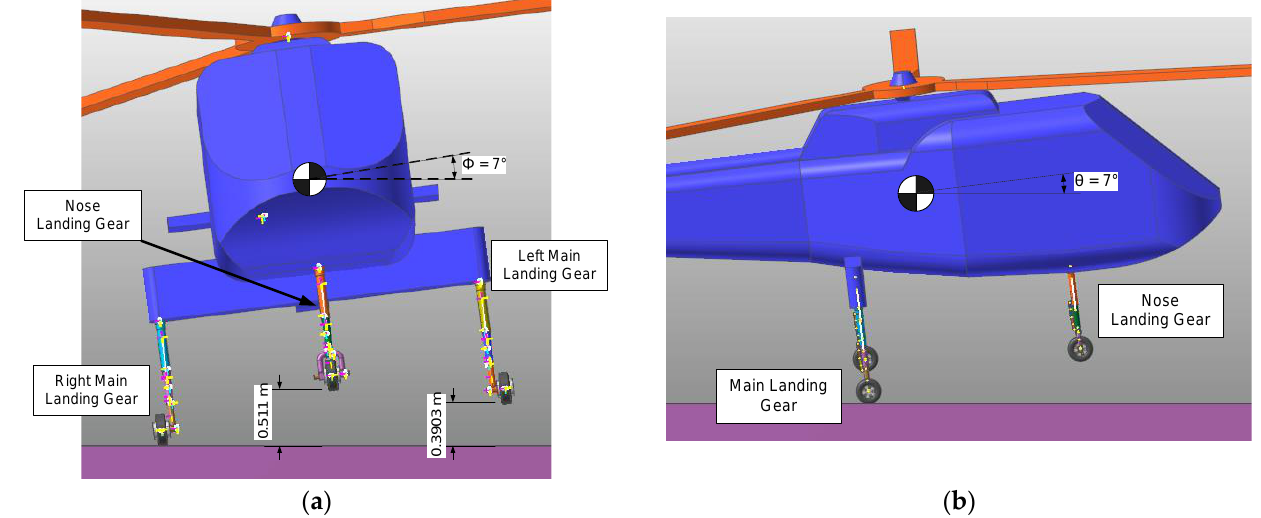
Figure 13. The simulation setup at θ = 7 ° and Φ = 7 ° . ( a ) Front view; ( b ) Side view.